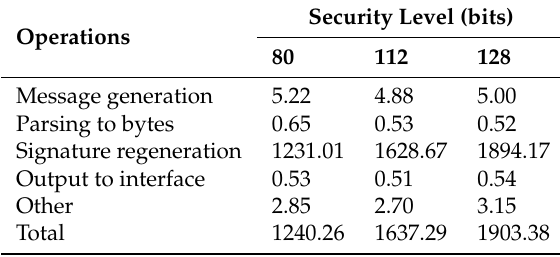
Table 8. Processing time (ms) for transmitter operations.